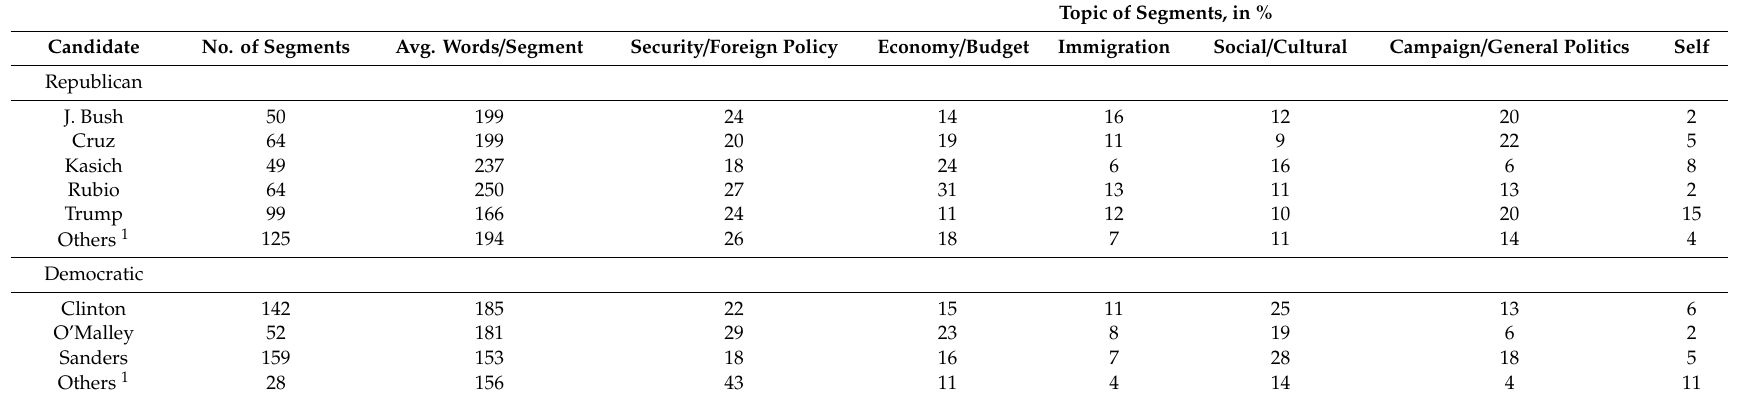
Table 2. The distribution of segments across candidates and subject matter.